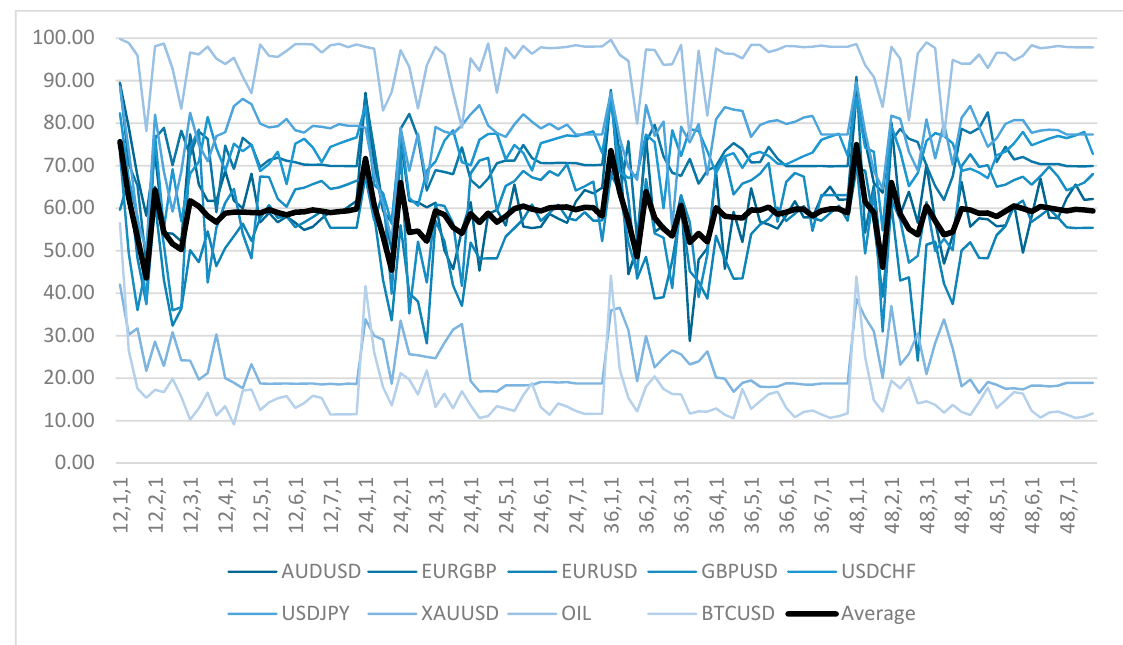
Figure 14. Net Profits of experiment (g) for various combinations of N, x , y .